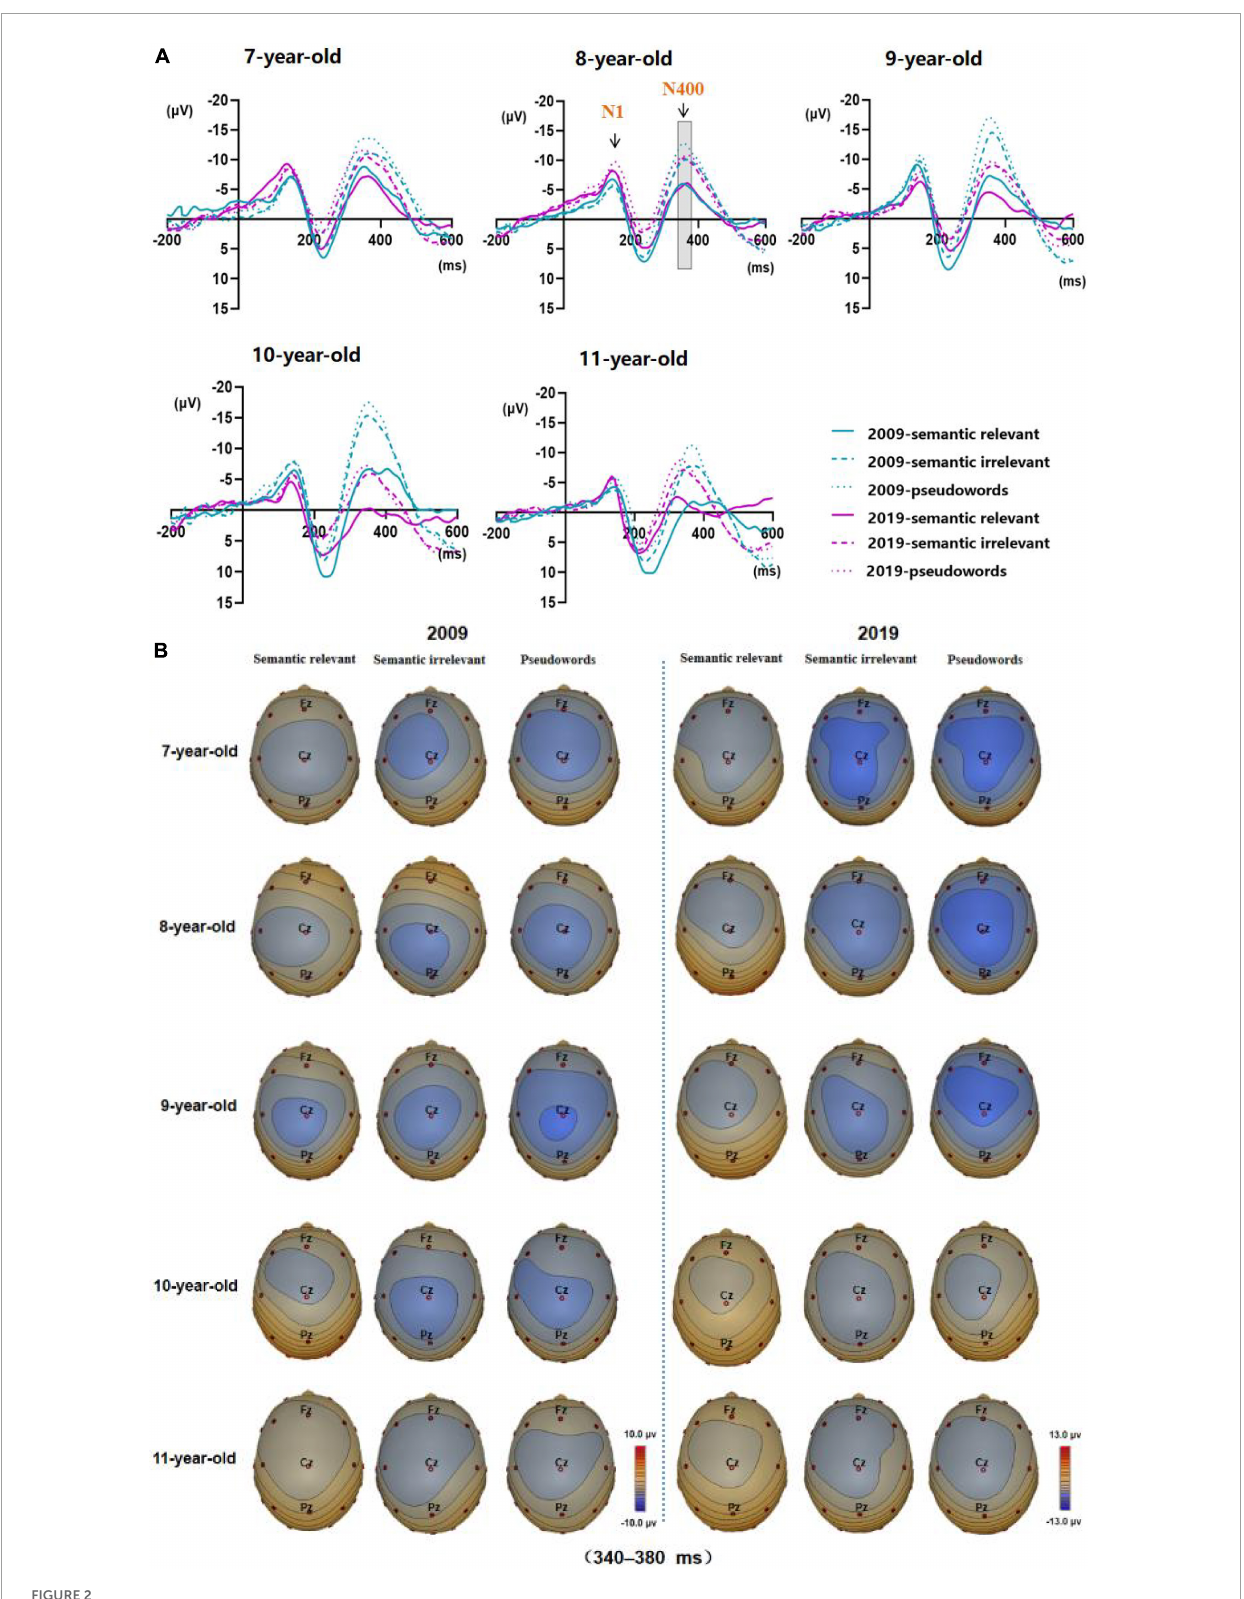
FIGURE2 Event-related potential and topographic map results. (A) ERP waveforms at central electrode (Cz) of children aged 7–11 years in 2009 and 2019. The green wave is 2009, and the red is 2019. In addition, the solid line represents semantic relevant, the broken line represents semantic irrelevant, and the dashed line represents pseudowords. (B) Mean topographic map at 340–380 ms of children aged 7–11 years. Fz, Cz, and Pz electrodes are